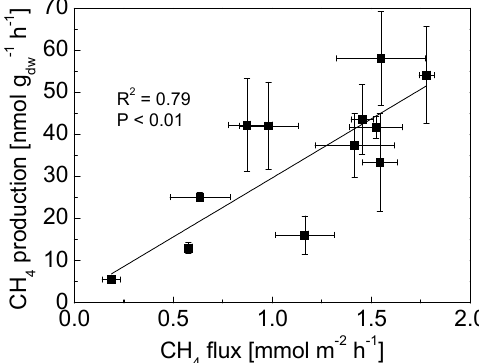
Fig. 1. Rates of CH 4 production and CH 4 emission measured during incubation of planted rice microcosms without and with addition of rice straw; means ± SD ( n =